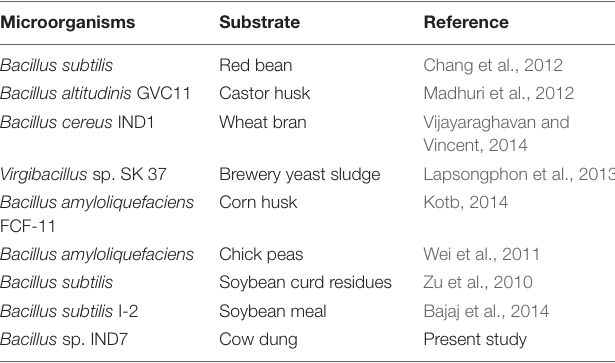
TABLE 1 | Fibrinolytic enzyme production on various agroindustrial residues in solid-state fermentation from bacterial isolates. Microorganisms